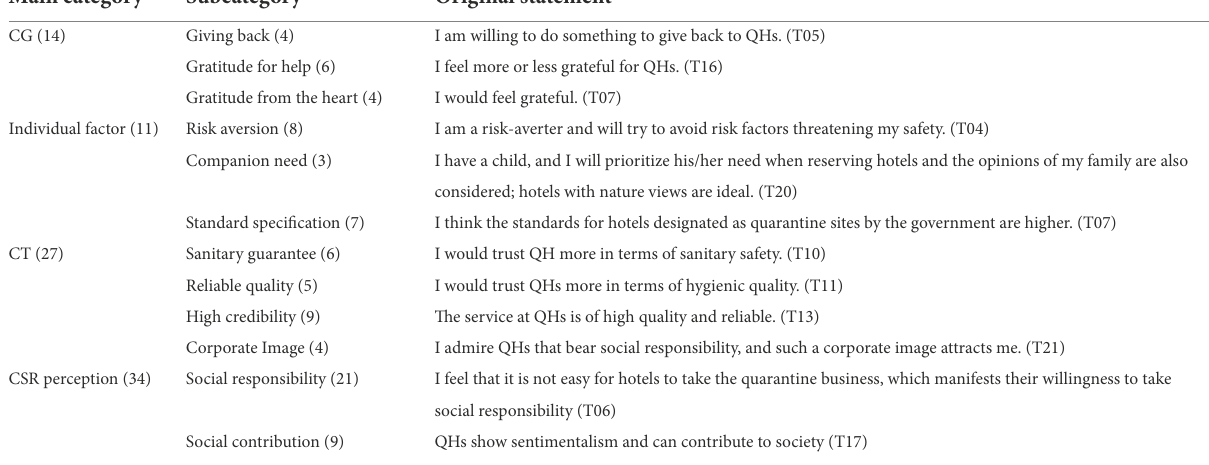
TABLE 1 Results of axial